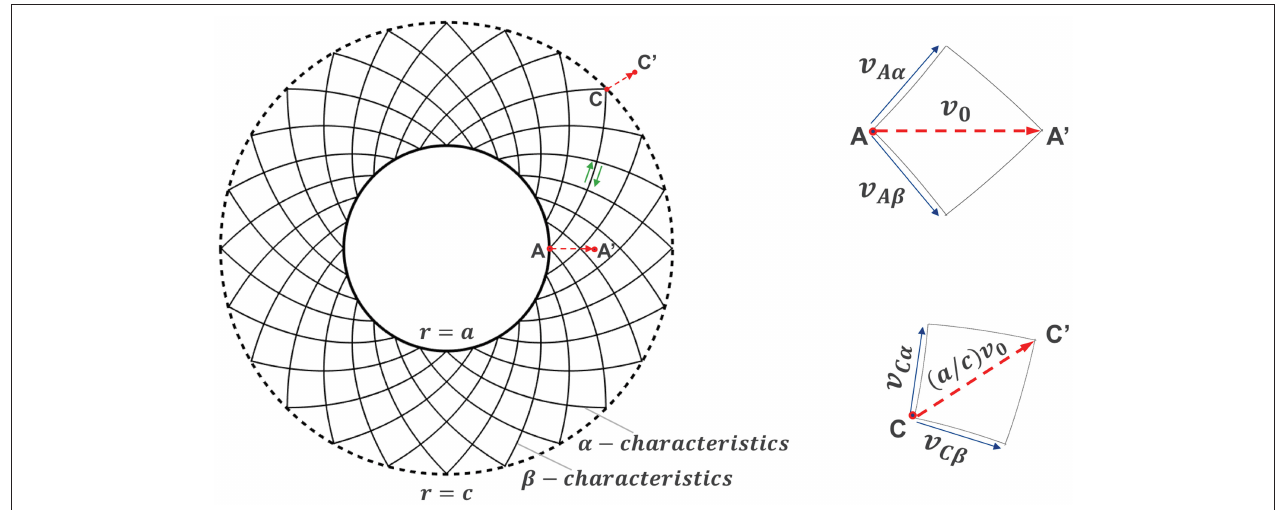
FIGURE 3 | Zoom-in of the inner plastic zone ( a < r < c ) with constant velocity boundary conditions (i.e., the upper bound approach). The velocity distribution around a circular cavity is a radial expansion. This expansion is enabled by slip lines in the form of logarithmic spirals: orthogonal lines of α -characteristics and β -characteristics for plane strain von Mises plasticity. The radial velocity at point A (a random point on the interior r C is ( a / c ) v 0 via the hodograph solutions from Johnson et al. (1983).